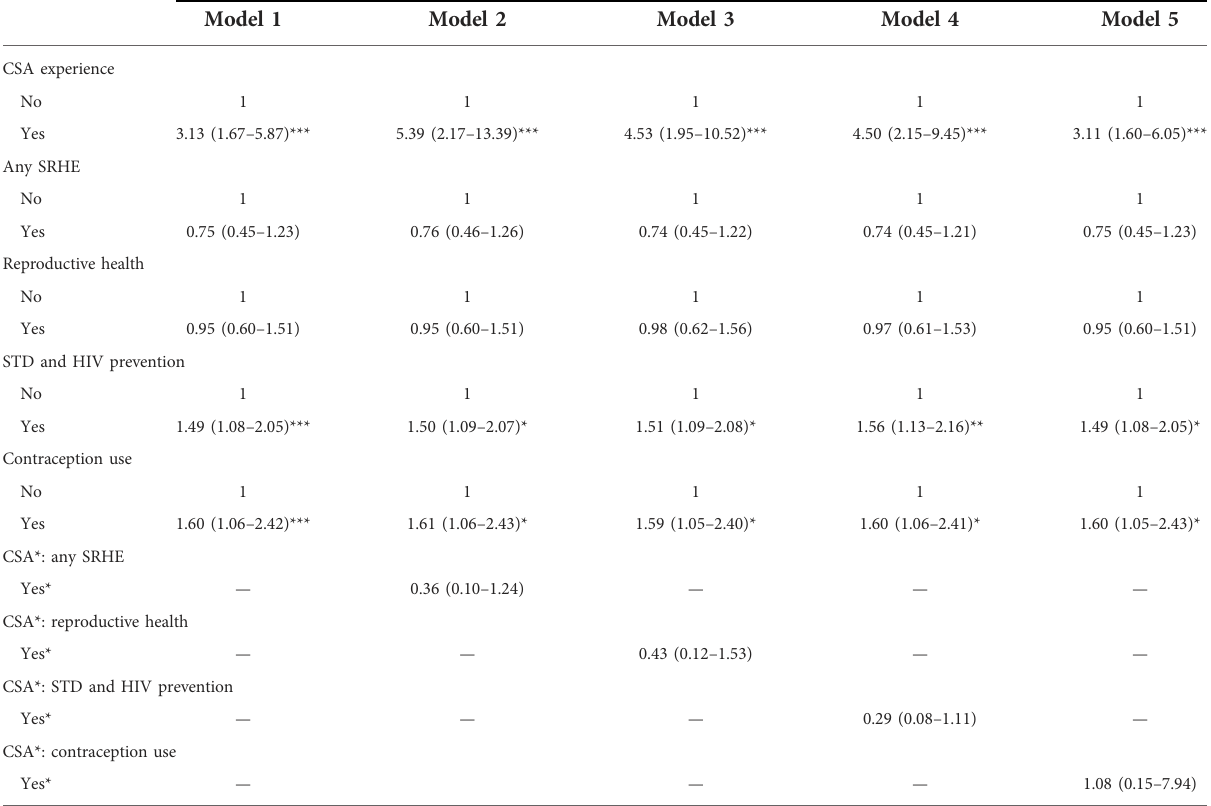
TABLE 4 Association between CSA experience, sexual and SRHE, and early sexual debut: adjusted odds ratio and 95% CI.